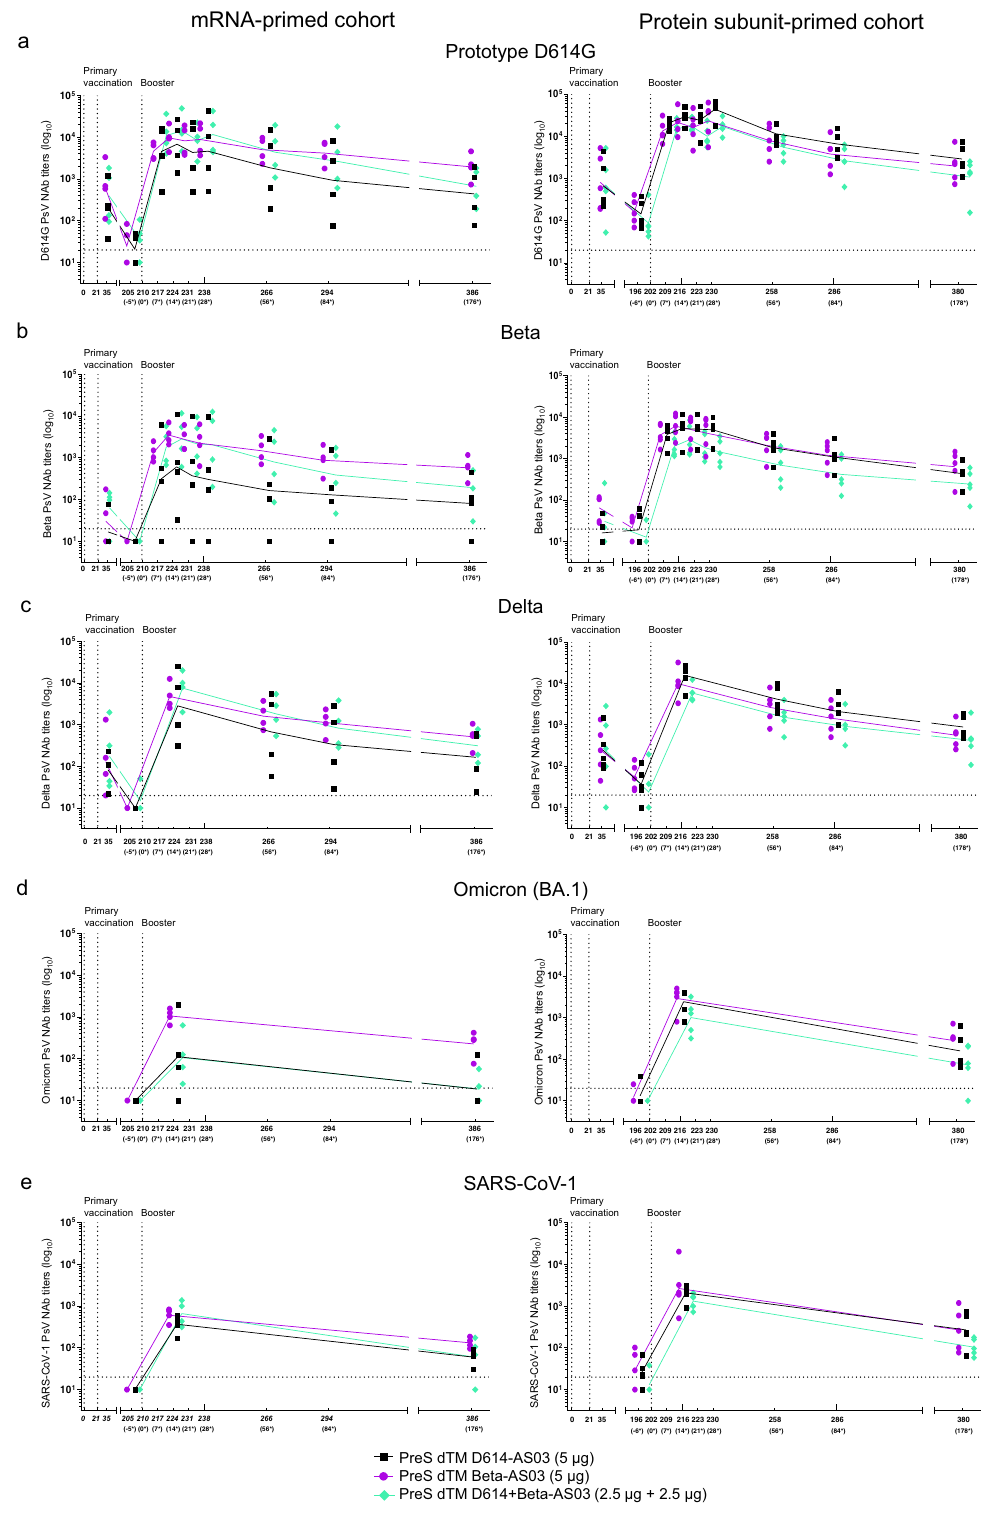
Fig. 2 | Kinetics of booster-neutralizing antibody responses in primed maca- ques. Pseudovirus-neutralizingantibodyagainst a theprototypeD614G,variantsof concern b Beta, c Delta,and d Omicron (BA.1),and e SARS-CoV-1 wereassessed up to D176 (mRNA-primed macaques, n =4) or day 178 (protein-primed macaques,